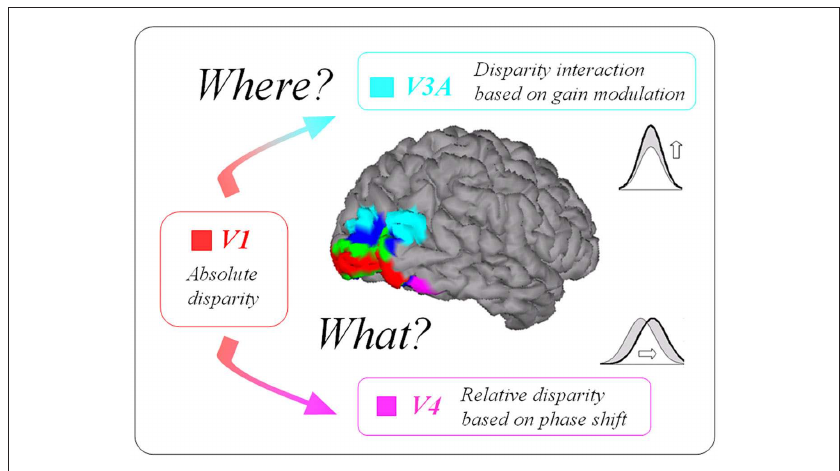
Figure 1 | Different processes for disparity interaction in the primate brain. While interactions would be based on gain modulation in the dorsal pathway, phase shift of the disparity-tuning curves would be observed in the